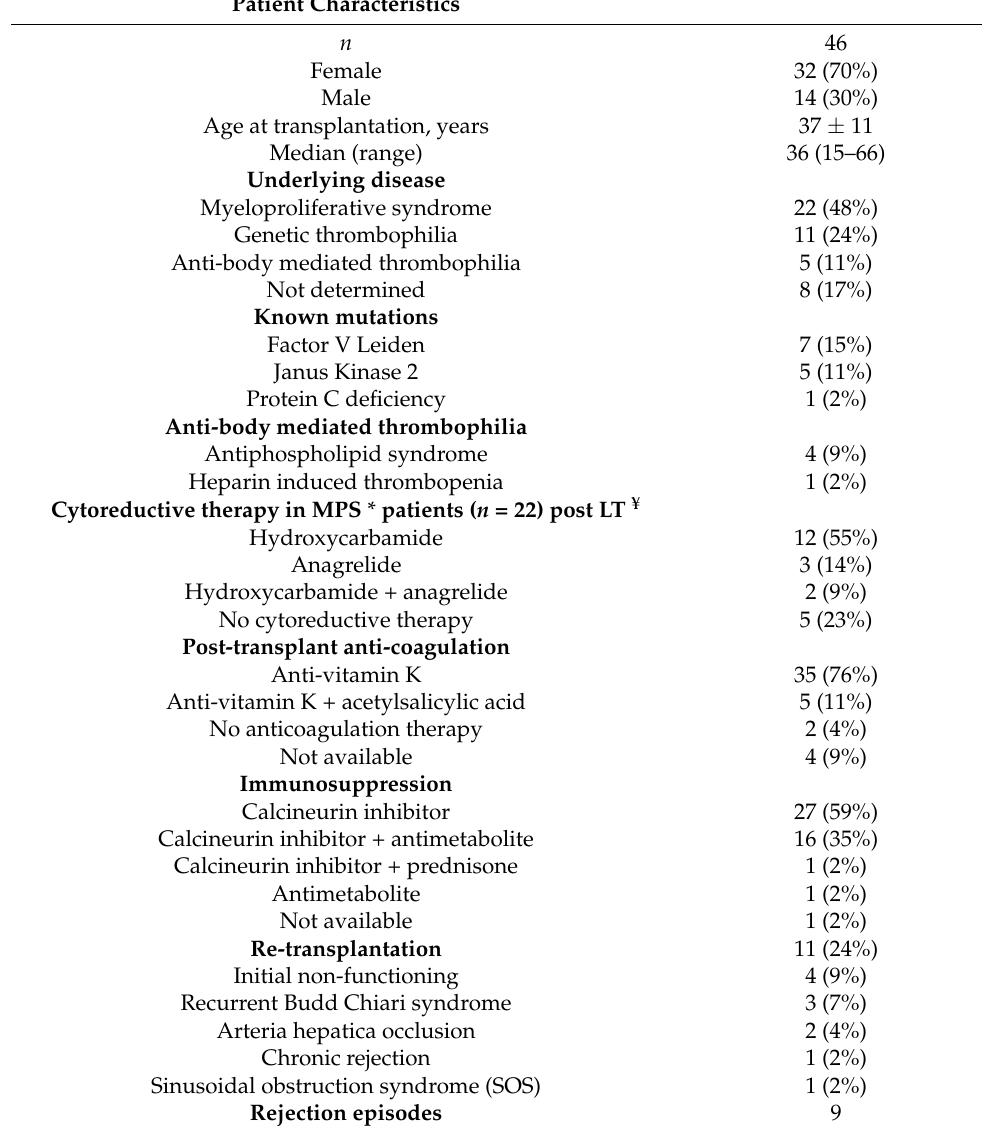
Table 1. Descriptive characteristics of the study group: patients transplanted for Budd-Chiari syndrome (BCS), mean ± SD or n